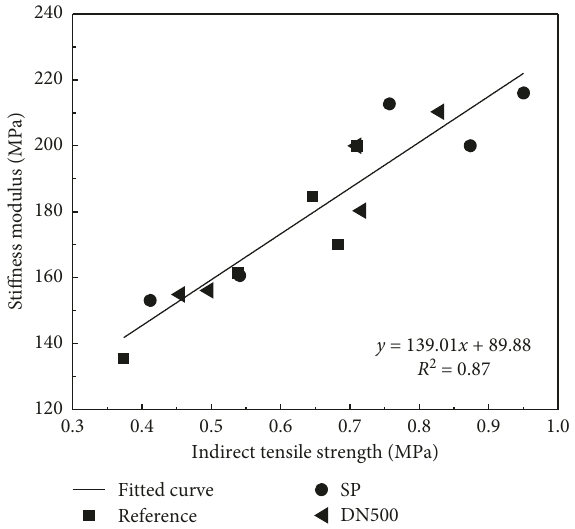
Figure 13: Relationship between CSED and ITS with different surfactants.